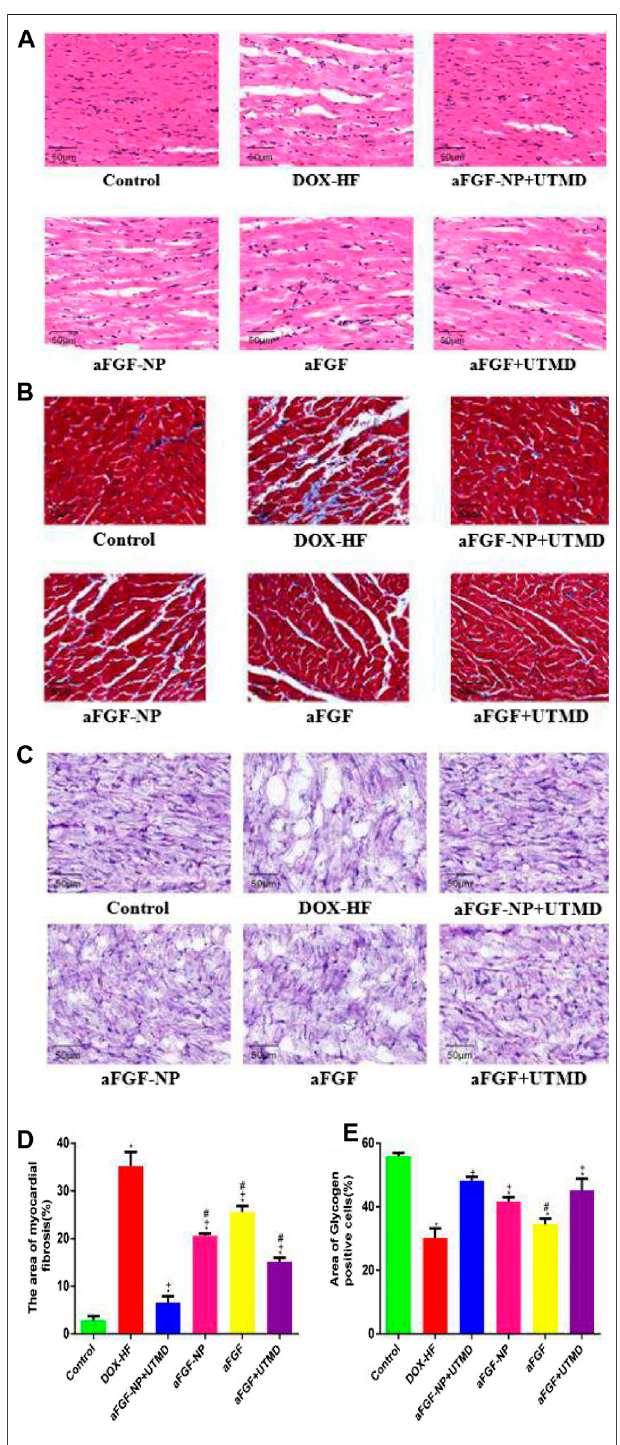
FIGURE 4 | The aFGF – NP + CPMBs combined with UTMD alleviated the pathological changes of myocardial tissue in DOX – HF rats. (A) : Representative photos of HE staining (400x); (B) ): Representative photos of Masson staining (400x); (C) : Representative photos of PAS staining (400x); (D) : Quantitative analysis of the degree of myocardial fi brosis in each group; (E) : Quantitative analysis of glycogen content in myocardial tissue of